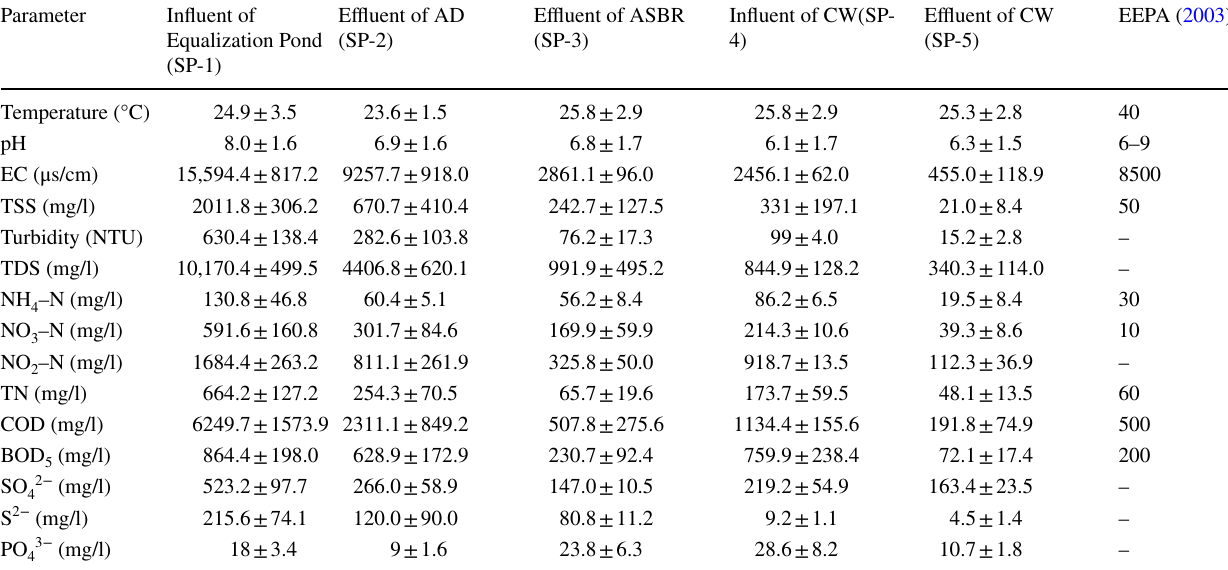
Table 3 Characteristics of the wastewater at different stages of the WWTP